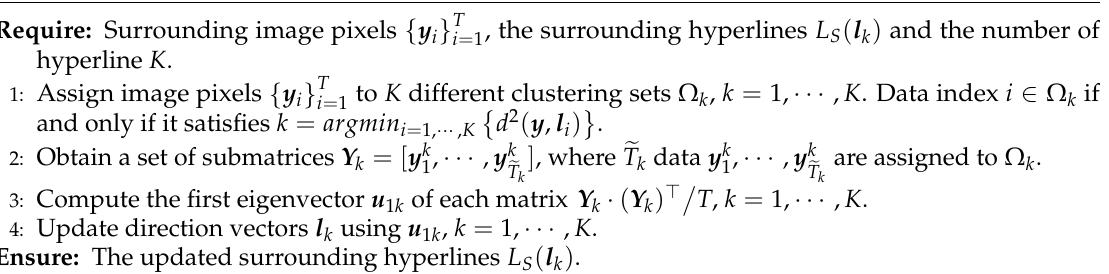
Algorithm 1 The update scheme of surrounding